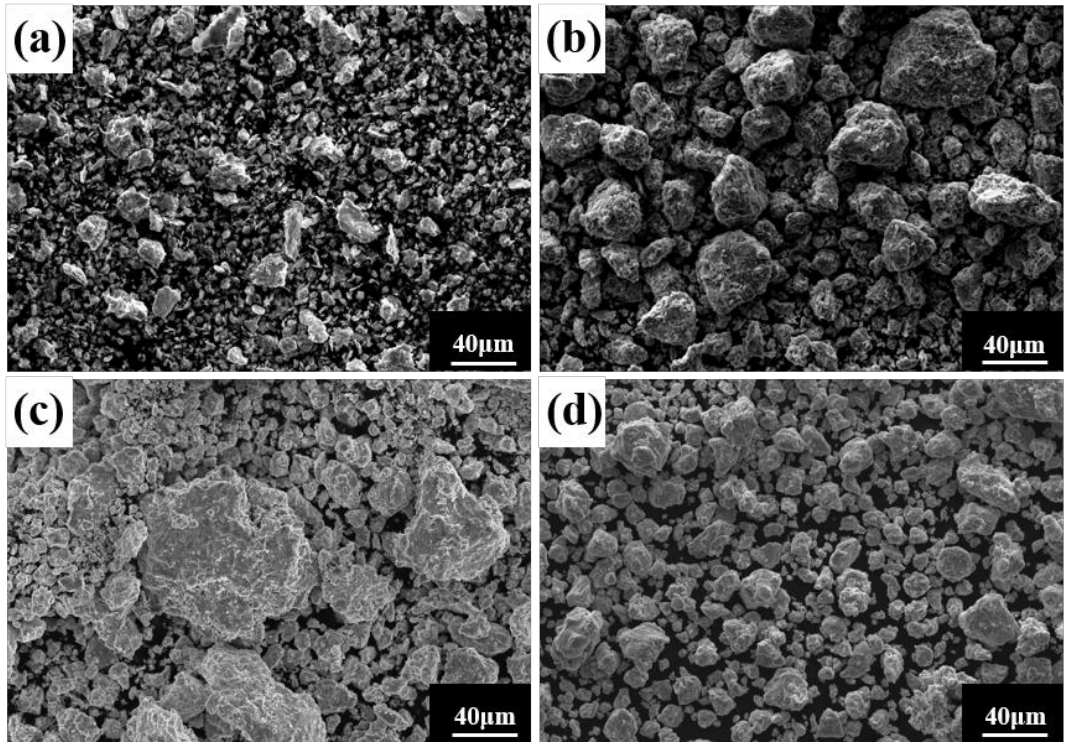
Figure 3. Powder microstructures at different milling times with a milling speed of 300 r min −1 and ethanol PCA: ( a ) 10 h; ( b ) 40 h; ( c ) 60 h; and ( d ) 80 h.